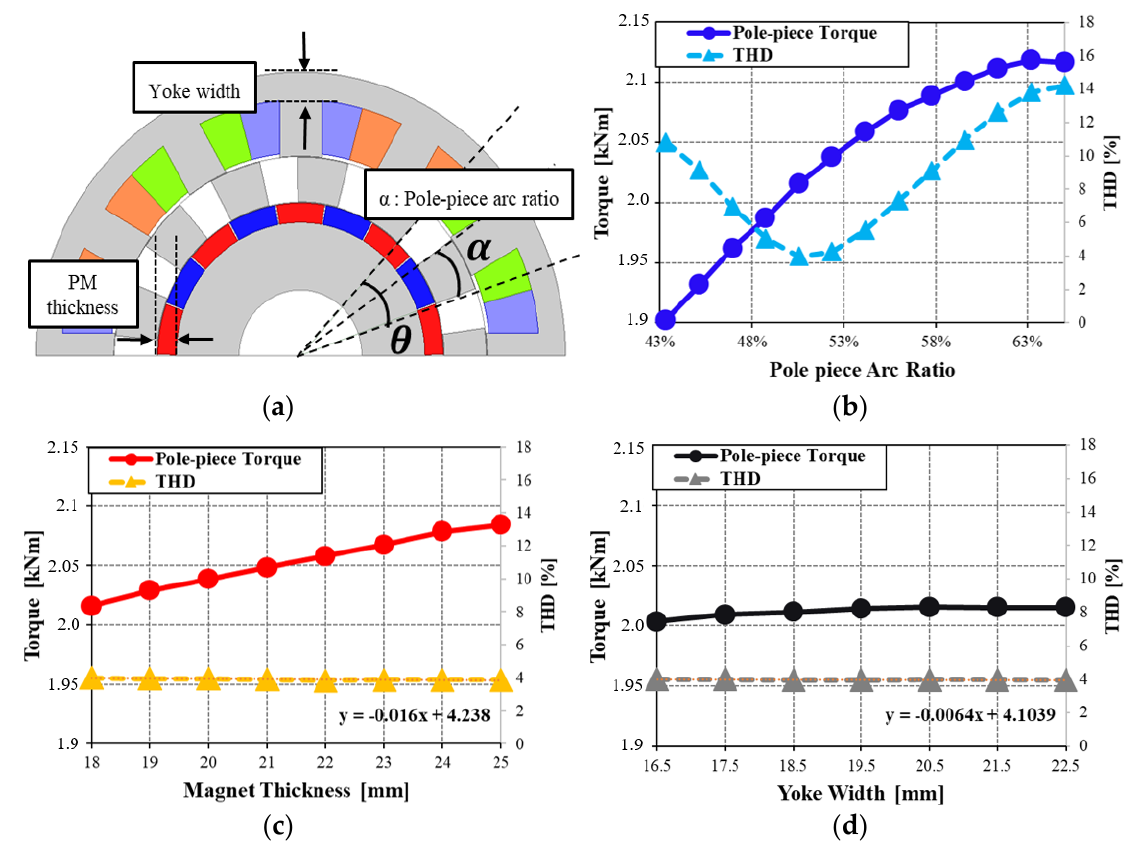
Figure 10. Detailed design parameters selected to derive the final 45kW MG ‐ PMSM model and the results of sensitivity analysis of parameters: ( a ) Design parameters for sensitivity analysis; ( b ) Effects of change in PP arc ‐ ratio; ( c ) Effects of change in PM thickness; ( d ) Effects of change in yoke width.